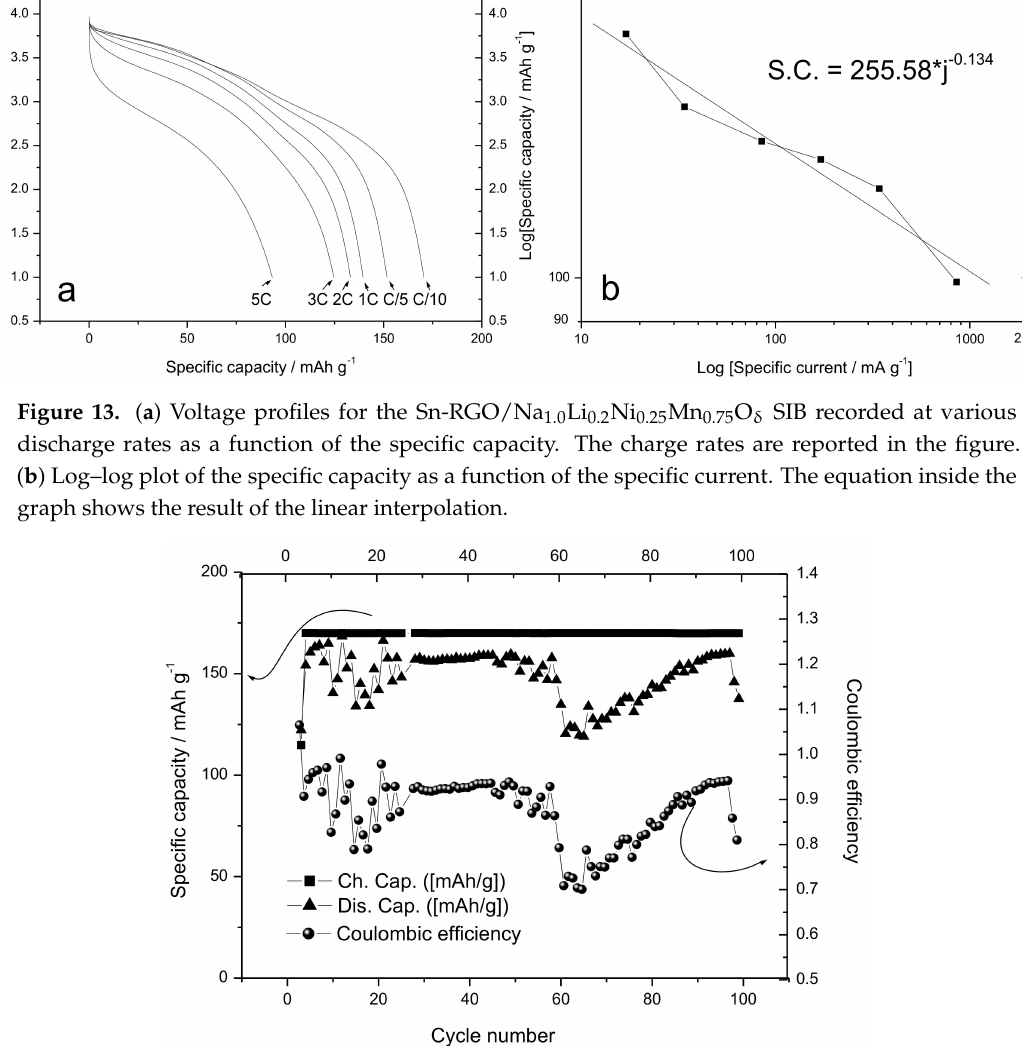
Figure 14. Specific capacity as a function of the cycle number for the Sn-RGO/Na 1.0 Li 0.2 Ni 0.25 Mn 0.75 O δ